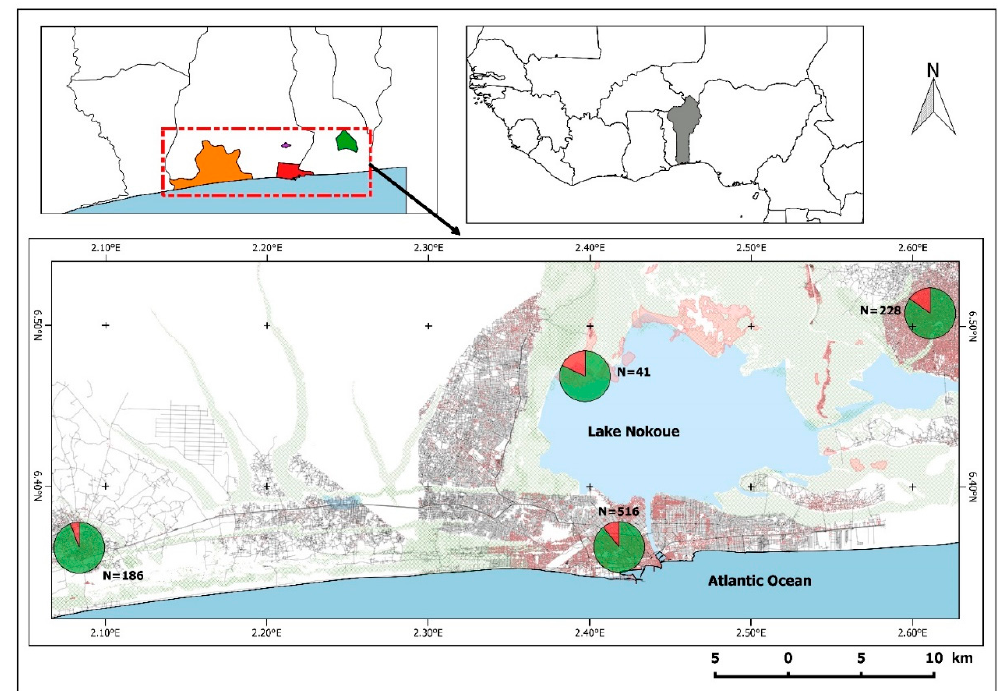
Figure 1. Sample size (green circles, N ) and overall rodent-borne Leptospira prevalence (red pie charts) in each of the four trapping zones from south Benin: Porto-Novo, Ouidah, Cotonou, and Ganvié, which correspond to the green, orange, red, and pink areas in the upper-left panel.